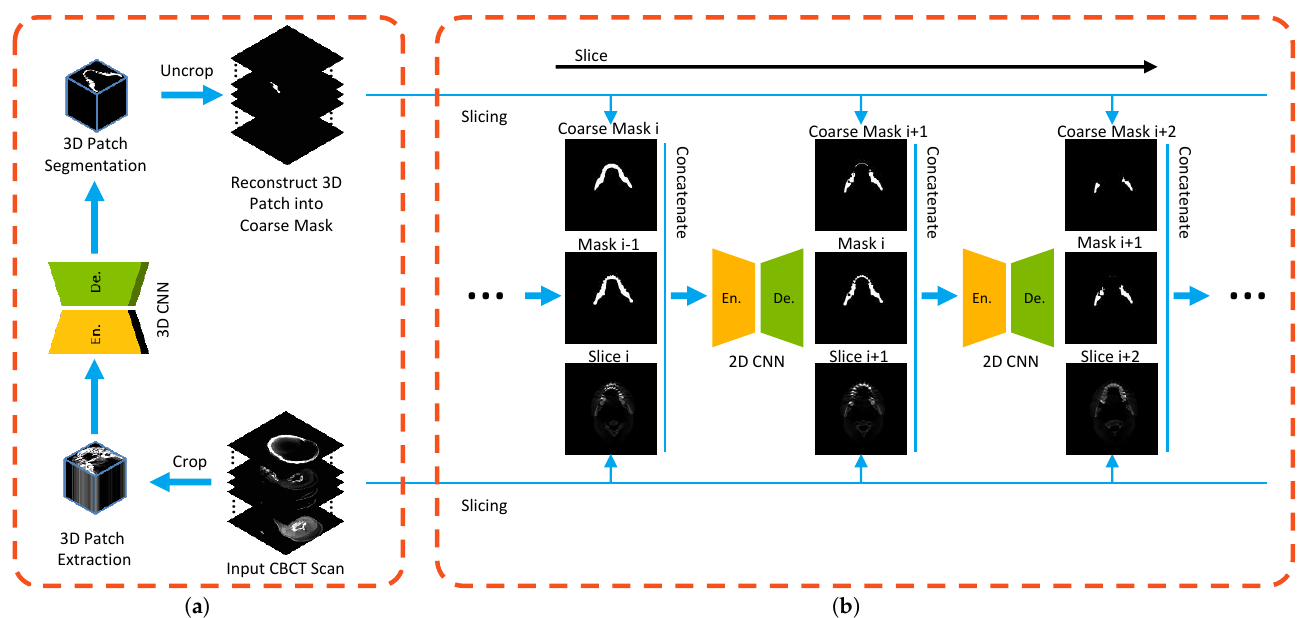
Figure 2. Overview of the proposed method consisting of ( a ) a 3D CNN for rough mandible segmentation and ( b ) a 2D recurrent segmentation network for further accurate mandible segmentation. The implementation of stage ( a ) is as follows: input scan → 3D patch extraction → 3D CNN (3D SegUnet based) → 3D patch segmentation → reconstruct the 3D patches into 3D segmentation of the scan. ( b ) The implementation of stage ( b ) is as follows: fusion with the coarse mask, the output probability maps and input data → RSegCNN (recurrent SegUnet) → accurate mandible